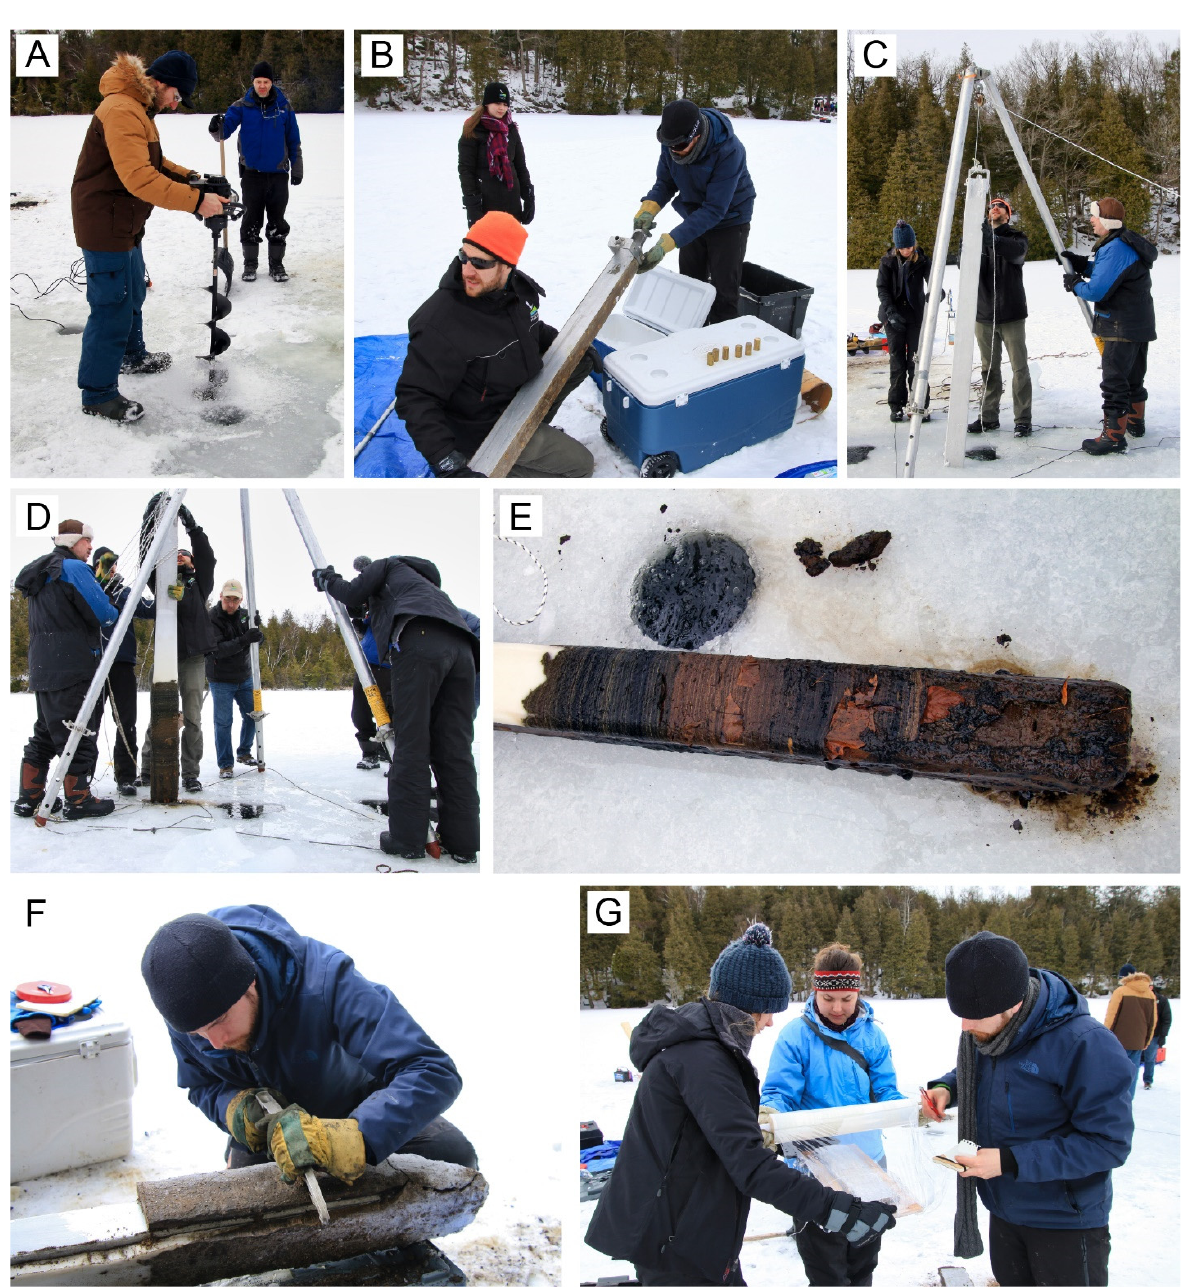
Figure 3. 2019 Coring at Crawford Lake. ( A ). Creating a hole in the ice for the coring device to be lowered through the water column to the lake bottom. ( B ). Filling freeze corer with a slurry of dry ice (solidified carbon dioxide) and ethanol. ( C ). Corer is lowered through the water into the sedi- ment water interface. ( D ). Freeze core is pulled back up to surface. ( E ). The corer laid out on the ice, metal side up, which under the winter conditions permitted the sediments to continue to solidify while photos and core logging took place. ( F ). Core being cleaned and sectioned for transport. ( G ). Sectioned core segments were laid on labeled boards and wrapped before being placed in dry ice packed coolers for transport to Carleton University.